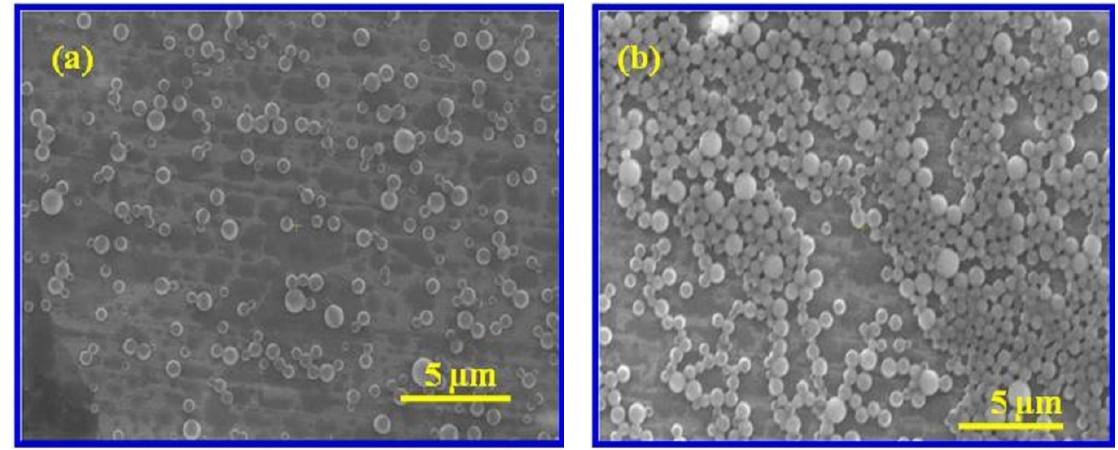
Figure 3. SEM images of curcumin drop-casted on the electrode before electropolymerization ( a ) and polycurcumin formed after 20 cycles of potentiodynamic electrolysis ( b ). Reprinted from [48] with permission from Elsevier.